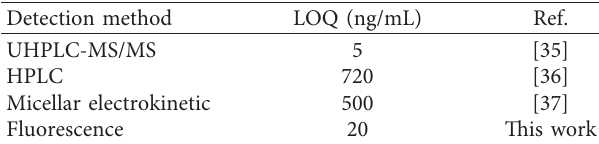
Figure 7: The concentration of catechin in Jiangxi black tea in- fusion. After removing the Raman effect, the fluorescence area fit image of the tea clear liquid increases with the concentration of catechin. The Pearson coefficient and the coefficient of determi- nation of the fitted straight line in the figure are all greater than 0.999. All experimental data are averaged after three experiments. Table 1: Different methods for the determination of